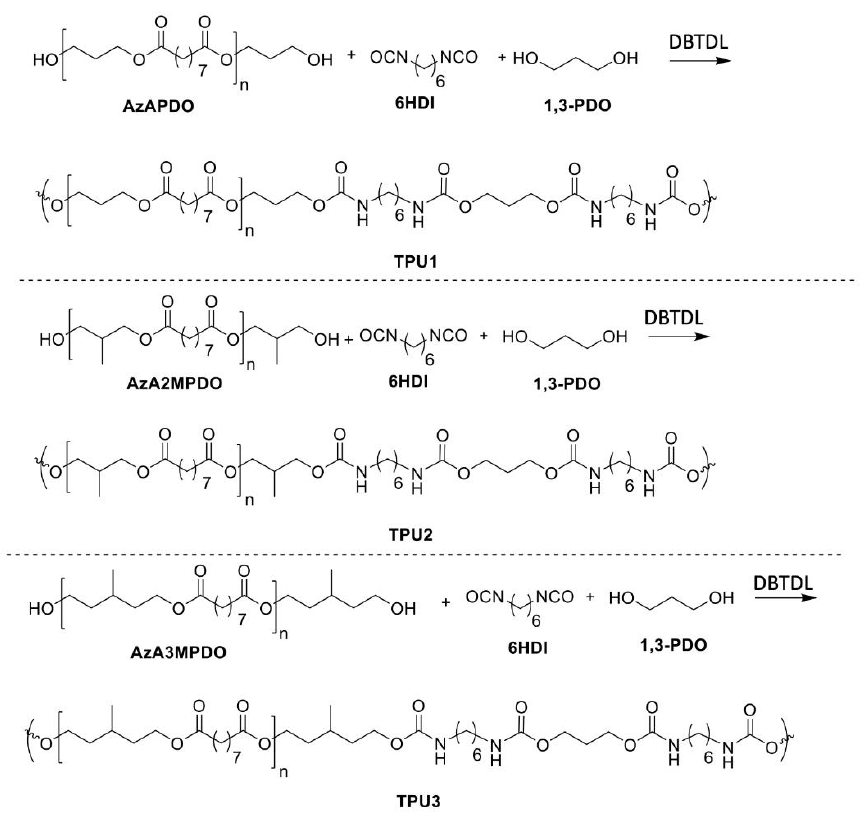
Table 3. Designations, chemical compositions, the molar ratio of monomers used in the preparation of TPUs, and percent bio-carbon content for